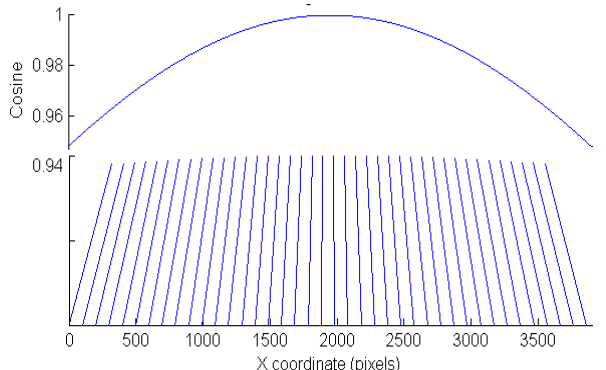
Figure 8. (top) Cosine value and (bottom) angle of projection vector across the image width.